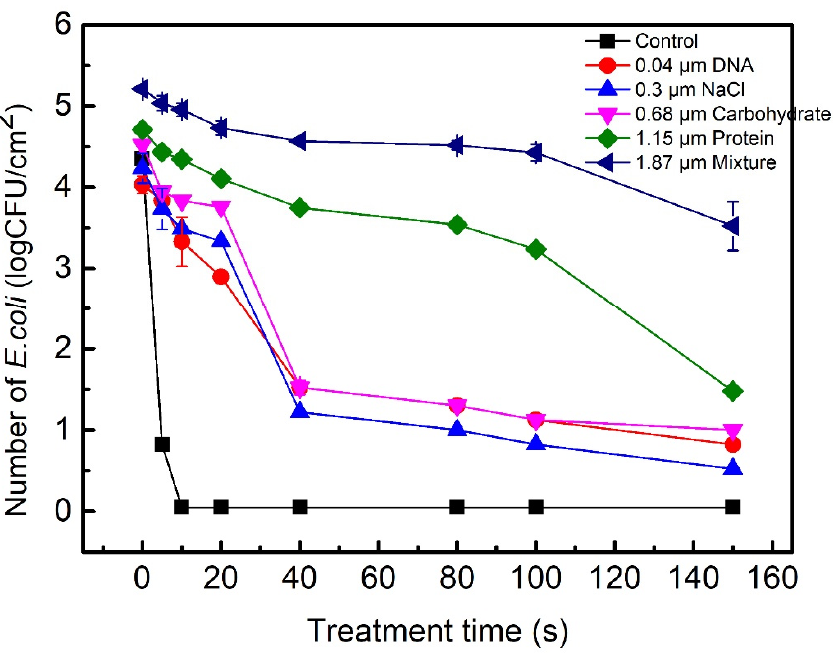
Figure 3. The number of surviving E. coli in the biofilms containing proteins, carbohydrates, DNA, salt or their mixture as a function of the plasma treatment time. The plasma inactivation was performed at V PP = 8.25 kV and a power of 460 W; 10 µ L of the aqueous solutions containing E. coli and constituents of biofilms was spread onto each steel disc (1.0 cm 2 ) and placed for 10 min under air flow in a biosafety cabinet to allow drying. After drying, the thicknesses of proteins, carbohydrates, DNA, salt, and their mixed biofilms were 1.15 µ m, 0.68 µ m, 0.04 µ m, 0.3 µ m, and 1.87 µ m, respectively. The mixed biofilms contained 2% DNA, 19% NaCl, 29% carbohydrates, and 50% proteins. The steel discs with dry biofilms were placed into the humidified air DBD chamber for plasma inactivation. Means ± standard deviations of experiments carried out at least in triplicate are shown.